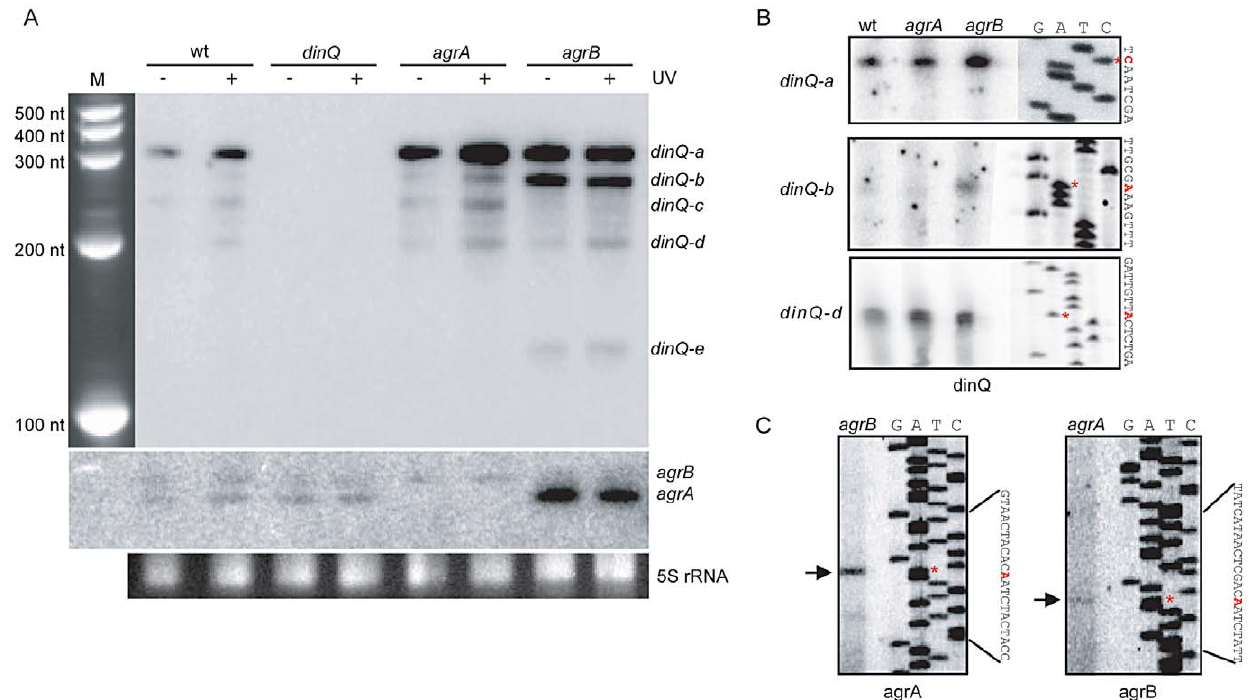
Figure 2. Expression pattern and transcription start of the dinQ/agrAB locus. (A) Northern analysis of dinQ and agrAB transcripts. A riboprobe specific to either dinQ (upper panel) or agrAB (lower panel) was hybridized to a northern blot with total RNA extracted from strains lacking dinQ (BK4040), agrA (BK4042) or agrB (BK4043) and compared to wt (AB1157) before and after UV exposure. Five dinQ transcripts assigned dinQ-a, -b, -c, -d and -e were detected. (B) A [ 32 P]-labeled primer specific to dinQ was used in a primer extension assay to determine transcription initiation sites of the various dinQ transcripts. The primer extension assays were performed on total RNA extracted from wt (AB1157) and mutant strains agrA (BK4042) and agrB (BK4043). The base annotated for transcription initiation is indicated with an asterisk (red) for each transcript. Three primer extension products were detected that correlated in size to dinQ-a, -b and -d from 3 9 mapping and the northern blot in (A). (C) A [ 32 P]-labeled primer specific to agrAB was used in a primer extension assay to determine transcription initiation sites of agrA and agrB . Total RNA from mutant strain agrB (BK4043) was used to localize agrA transcription start and total RNA from mutant strain agrA (BK4042) was used to localize agrB transcription initiation, due to the transcripts sequence complementarity. The base annotated for transcription initiation is indicated with an asterisk (red) for each transcript.